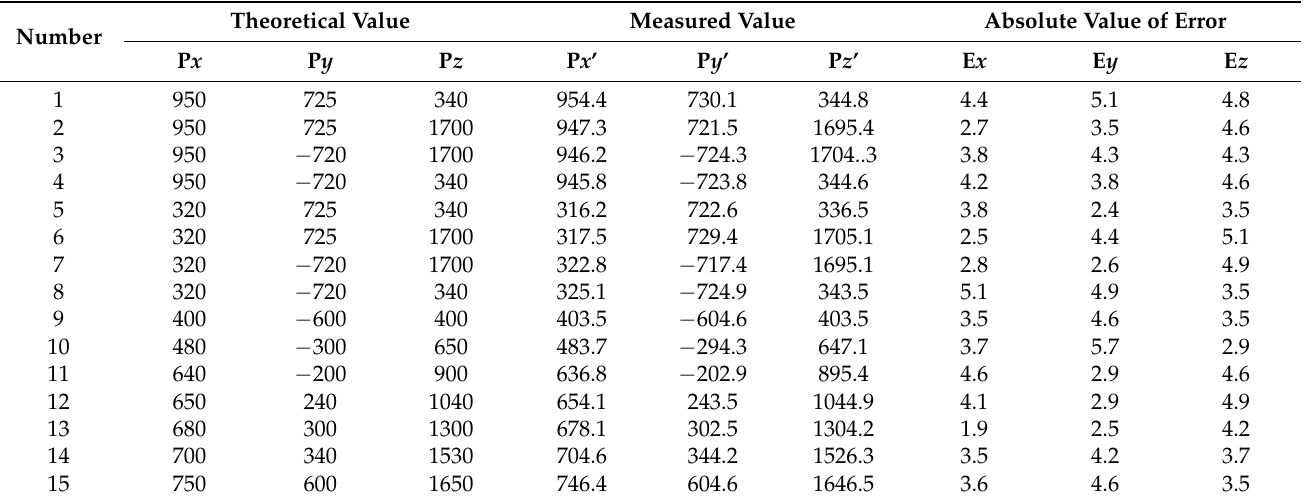
Table 2. Measurement results of the end position of the pollen-picking